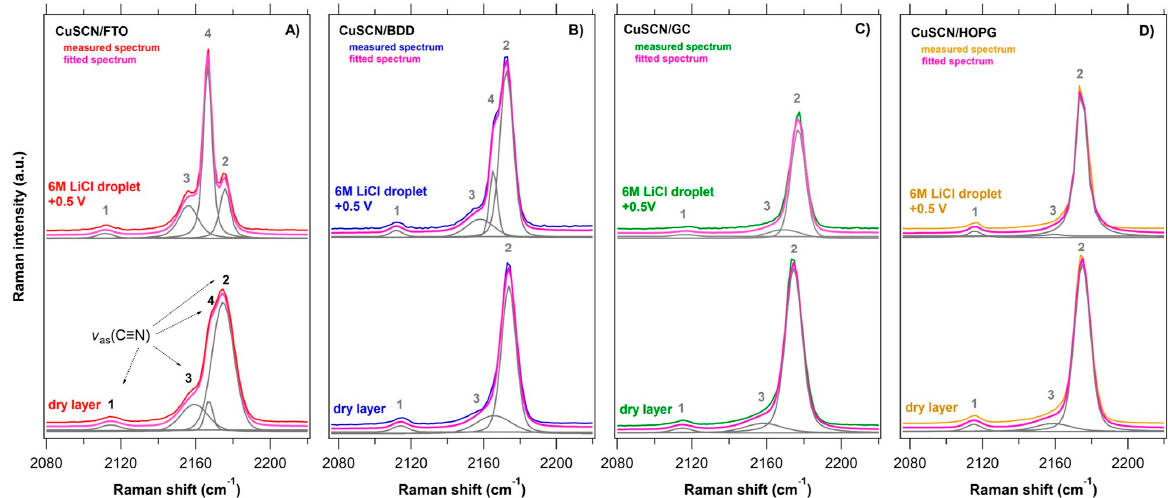
Figure 7. Raman spectra of the electrodeposited CuSCN (i) dry (ex situ) layers (bottom) and (ii) in 6 M LiCl at +0.5 V vs. Ag/AgCl upon in situ Raman- μ SEC measurement (top) on ( A ) FTO (red trace), ( B ) GC (green trace), ( C ) BDD (blue trace), ( D ) HOPG (yellow trace) substrates, in the region of SCN vibrations (2080–2200 cm − 1 ). The fit envelopes and individual peak components, obtained using Voigt approximation, are shown in pink and gray, respectively.